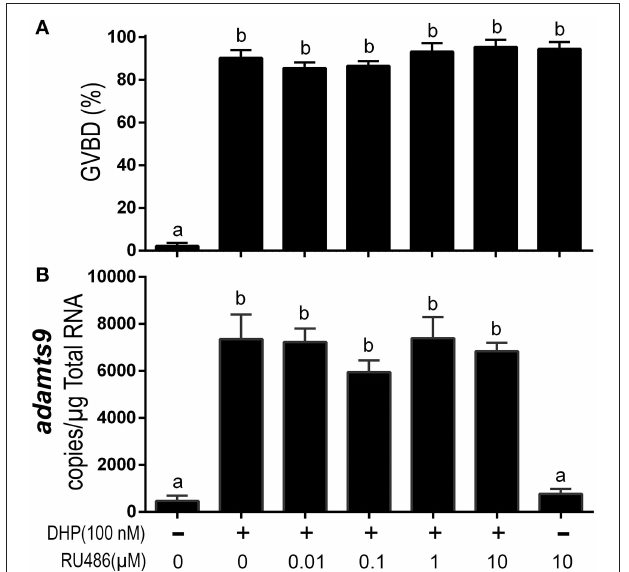
FIGURE 7 | RU486 induced oocyte maturation but did not attenuate DHP-induced expression of adamts9 . (A) Percentage of germinal vesicle breakdown (GVBD), (B) Expression of adamts9 transcripts. Letters on the bars indicate significant differences ( p < 0.0001). Experiment was repeated three times with results of one representative experiment presented as mean ± SEM. N = 4.